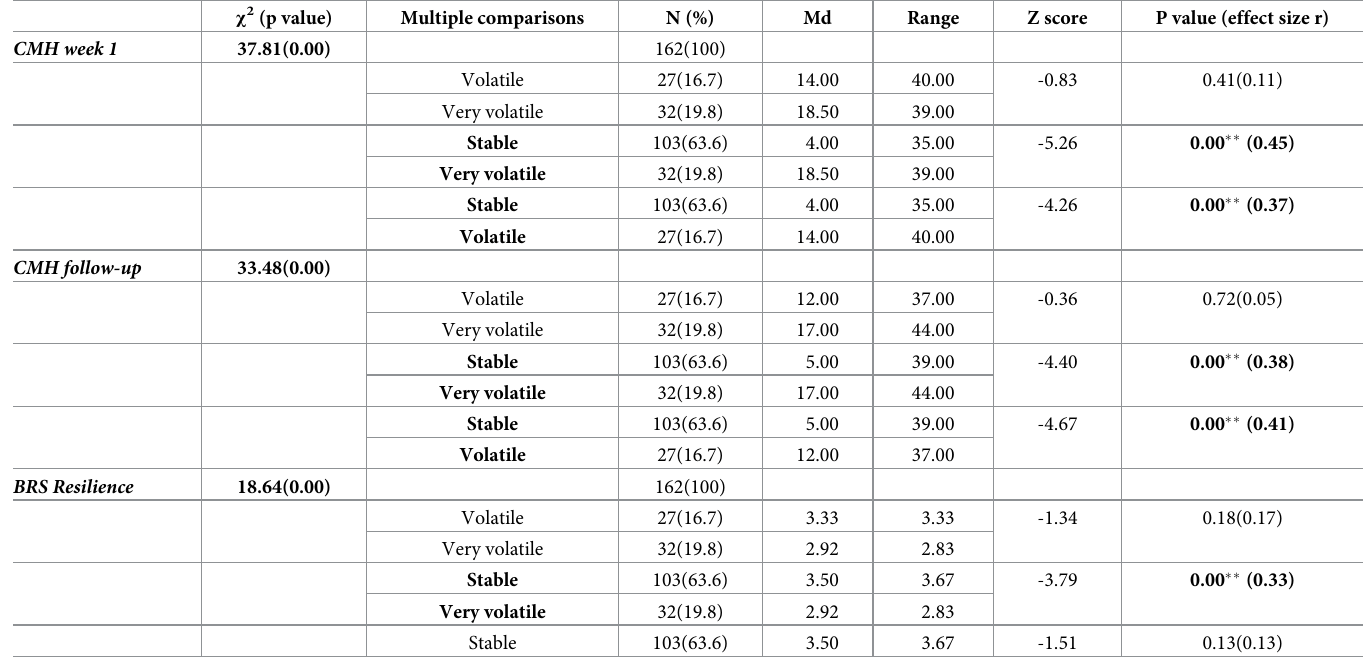
Table 4. Differences between the ‘stable’, ‘volatile’, and ‘very volatile’ groups in terms of mental health and resilience. Significant differences are bolded. χ 2 (p value)